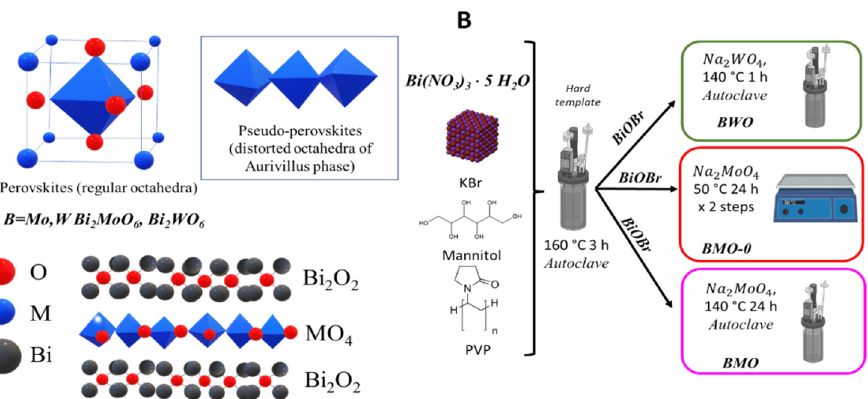
Scheme 1. ( A ) Structure of Aurivillius phase oxides; comparison between pseudo-perovskites layers and real perovskites [55]. ( B ) Methodologies employed for BWO and BMO synthesis from literature (red and green box) and by a new synthetic strategy (magenta box). BWO (Bi 2 WO 6 ); BMO (Bi 2 MoO 6